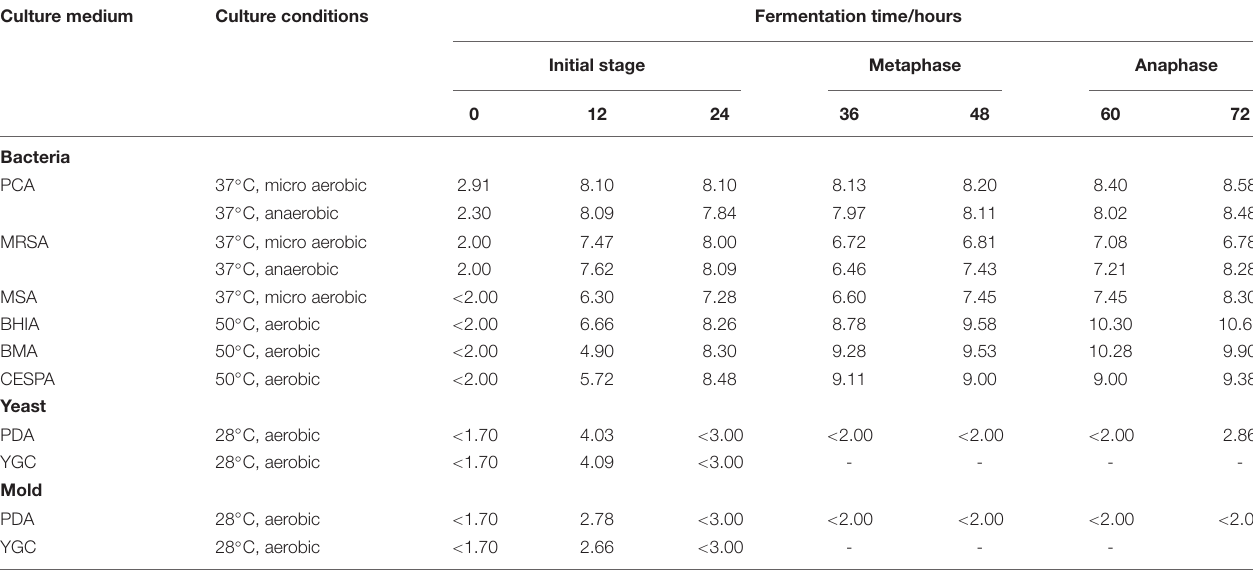
TABLE 2 | Evolution of microbial population in the non-post fermented Shuidouchi during fermentation (unit was log